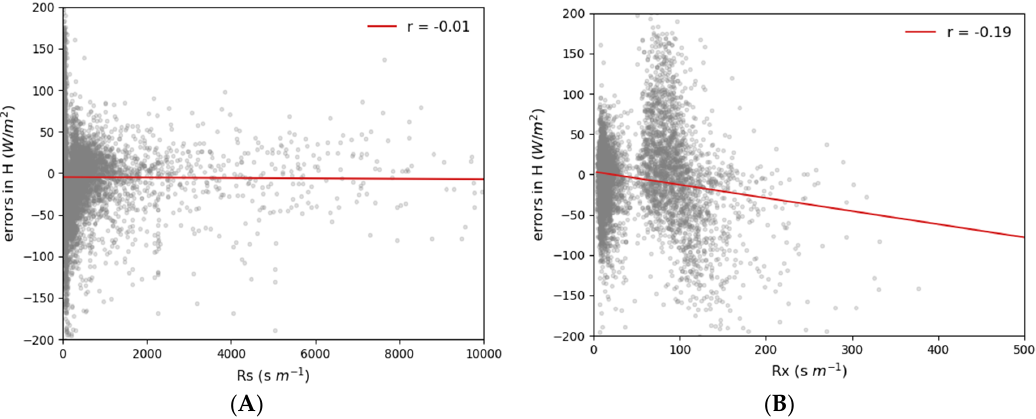
Figure A5. R s ( A ) and R x ( B ) vs residual H error for TSEB ‐ 2S at the CT in 2015.